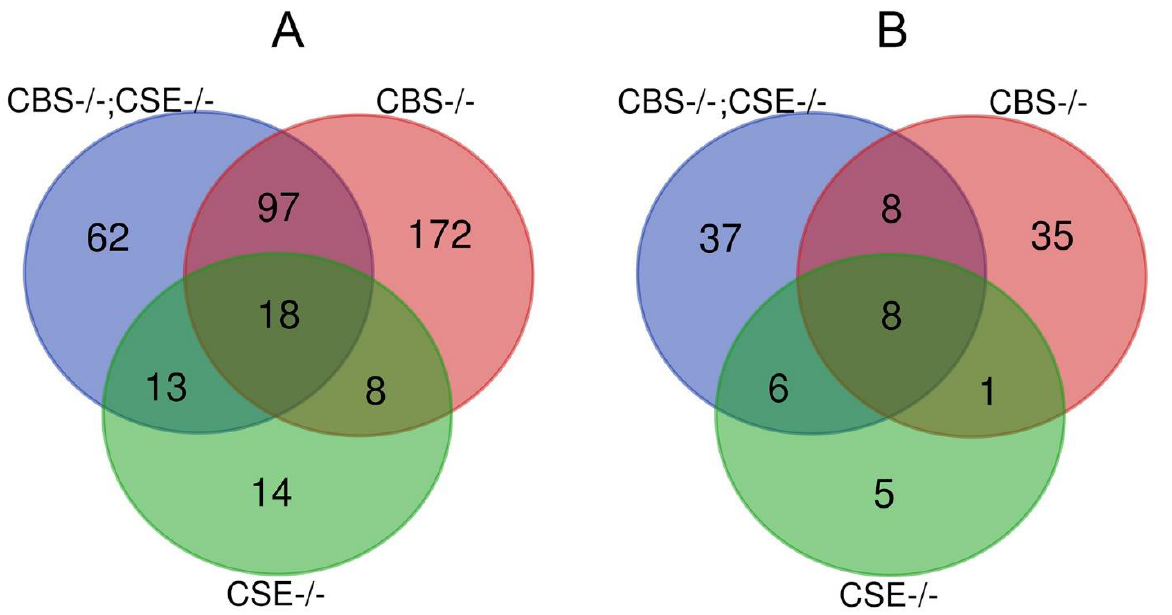
Figure 5. Venn diagram showing common and unique sets of differentially expressed genes between investigated strains ( CBS-/- ; CSE-/-: blue , CBS-/-: red , and CSE-/-: green) after pairwise comparison to control strain 548492 (FDR < 0.05); ( A ) Down-regulated genes. ( B ) Up-regulated genes.